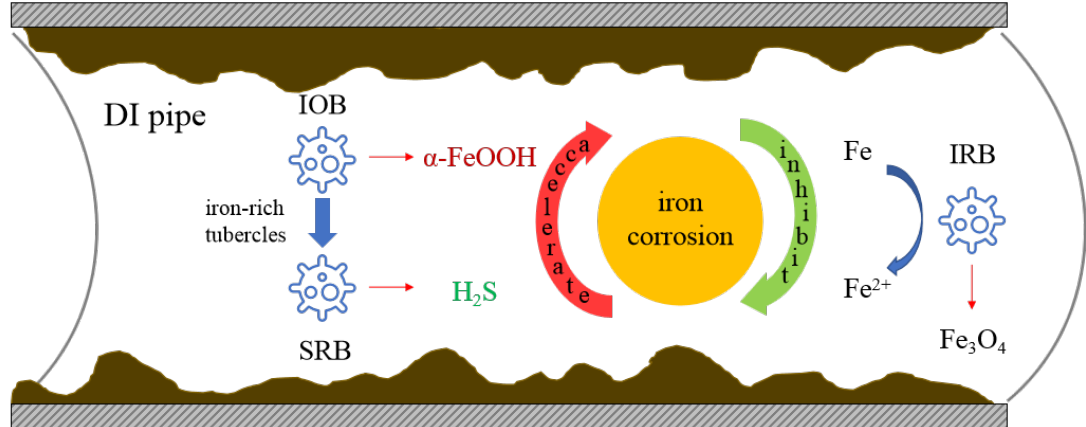
Figure 7. The relationship between bacteria (IOB, SRB, and IRB) and DI pipe corrosion.